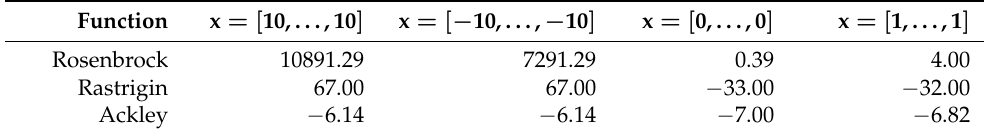
Table 2. The three test functions used in this work. The search space was set to [ − 10,10 ] , thus the shown values are the extreme possible values that the functions could take, also the minimum value is shown at the optimum solution x = [ 0, . . . ,0 ] , and the evaluation at x = [ 1, . . . ,1 ] is shown in the last column.